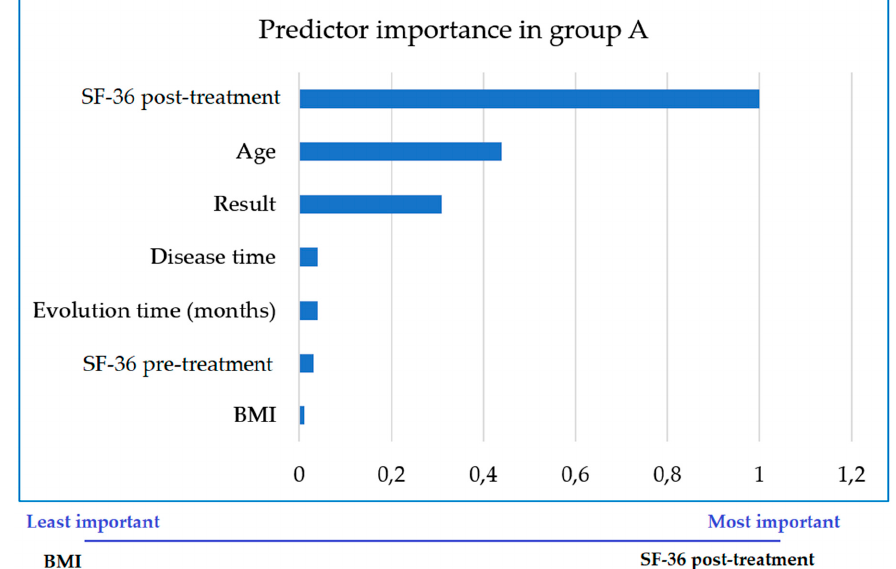
Figure 2. Importance of each variable as a predictor of the successful outcome of treatment in improving quality of life in women treated with adjunctive biofeedback (GA). BMI-Body Mass Index.